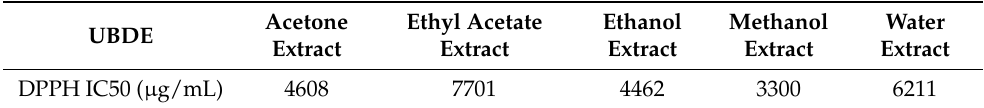
Table 3. DPPH IC 50 values for tested UBDE.